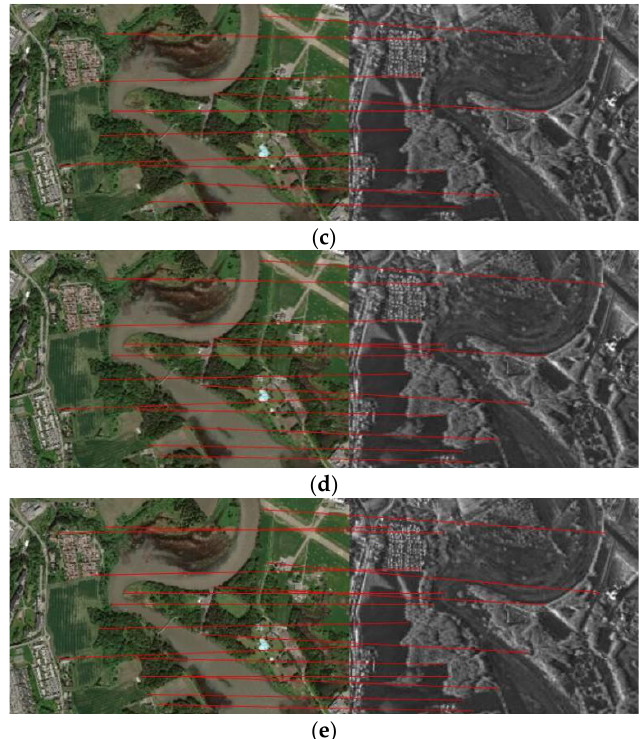
Figure 2. ( a ) Optical image; ( b ) SAR image; matches found in pair 1 using ( c ) SIFT, ( d ) SAR-SIFT, and ( e ) the proposed method. The reference image is shown on the left and the sensed image on the right.